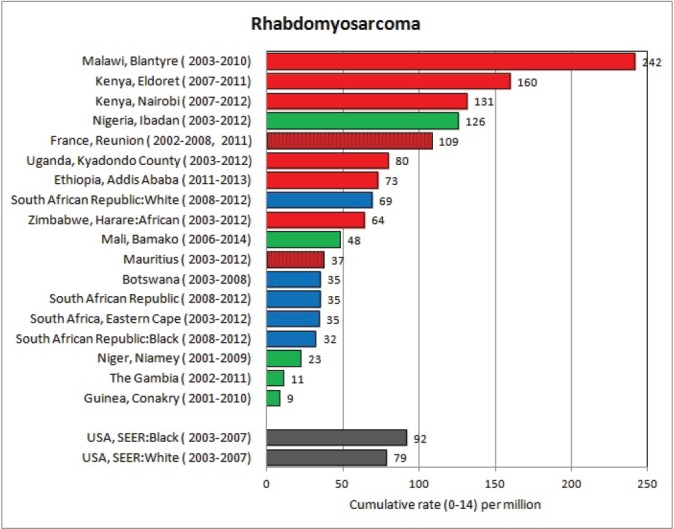
Cumulative (0–14) incidence rate—rhabdomyosarcoma.